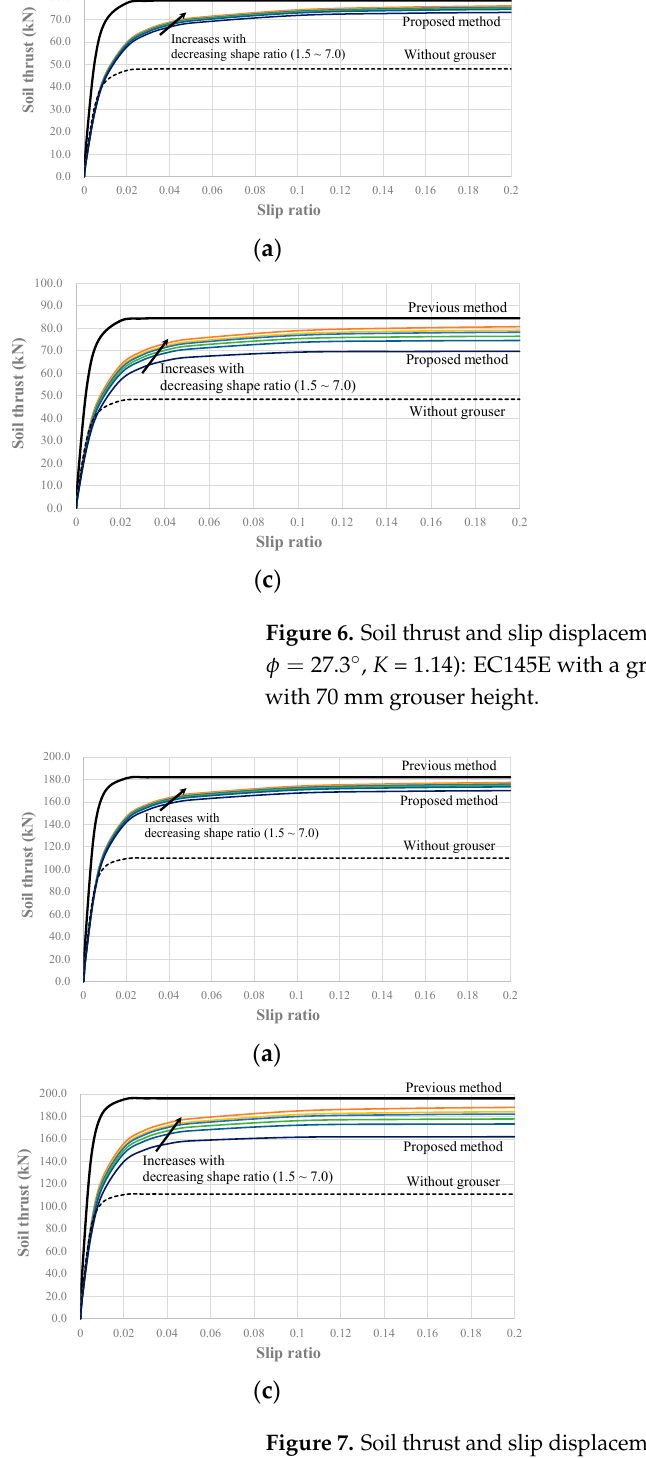
( d ) Figure 8. Soil thrust and slip displacement curves in soils exhibiting softening behavior ( c = 3.3 kPa, 𝜙 = 33.7° , K W = 9.3, K r = 0.835): EC145E with a grouser height of ( a ) 25 mm ( b ) 50 mm ( c ) 70 mm: ( d ) EC380E with 70 mm grouser height. ( a )